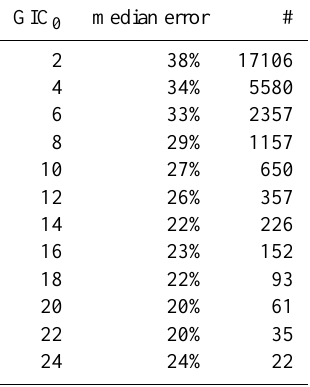
Table 5. Misfit of modelled GIC values at M¨ants¨al¨a during April, Table 4. Misfit of modelled GIC values at Rauma during the events September-November 2001, and during the other events listed in Ta- used in Table 3. The first column gives the lower limit of (absolute) ble 3. The first column gives the lower limit of (absolute) GIC val- GIC values considered. The second column gives the median error ues considered. The second column gives the median error of mod- of modelled values. The last column gives the number of measured elled values. The last column shows the number of measured 10-s one-minute values larger than GIC 0 . The Earth model is explained values larger than GIC 0 . The electric field was calculated using in the text only the magnetic data of the Nurmij¨arvi observatory. A uniform Earth model was assumed with a conductivity of 0.07663ohmm − 1 . GIC 0 GIC 0 median